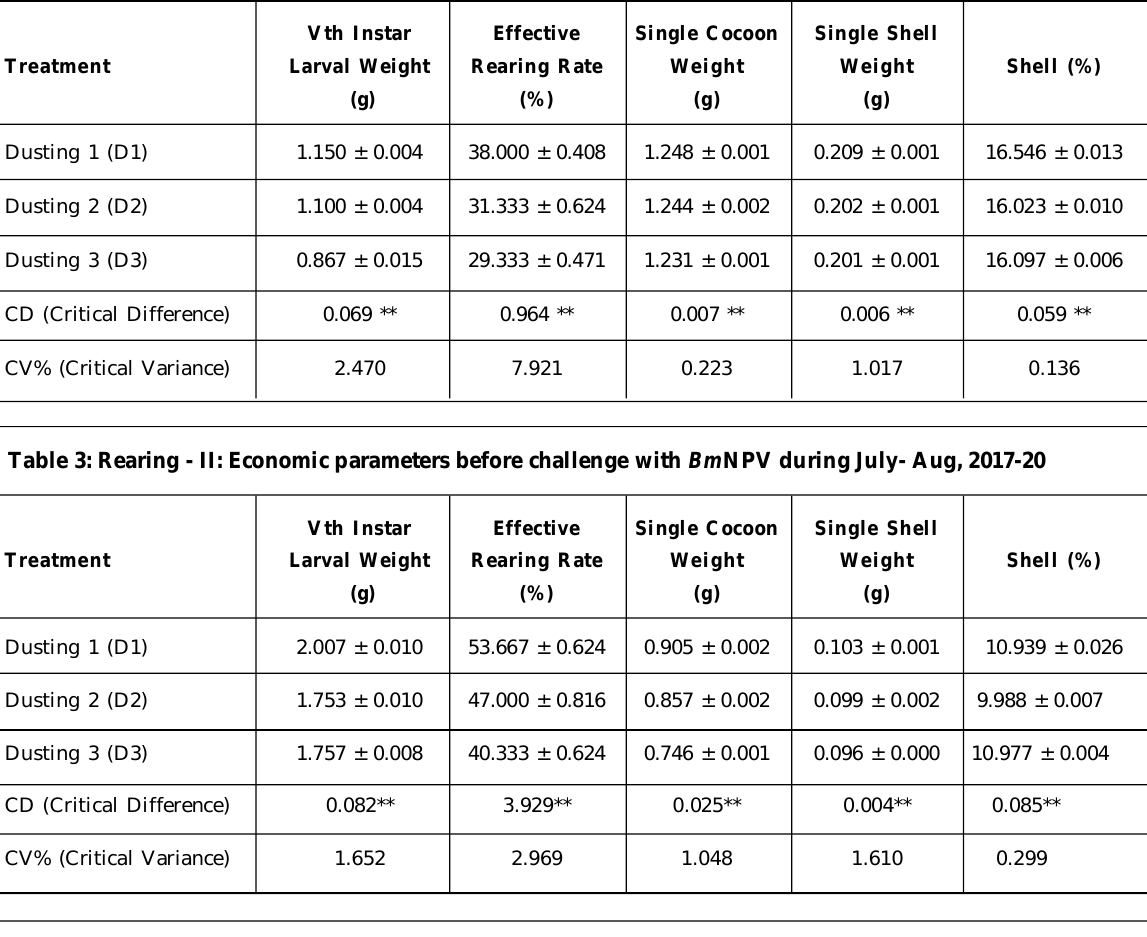
Table 4: Rearing - II: Economic parameters after challenge with Bm NPV during July- Aug,